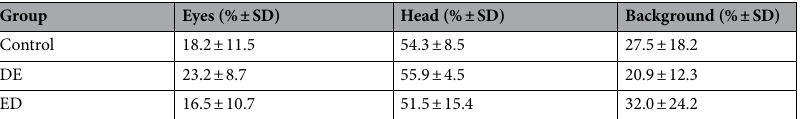
Table 2. Table 2 depicts the average percentage of time (and corresponding standard deviation, SD) that each group spent fixating within each dynamic interest area region.